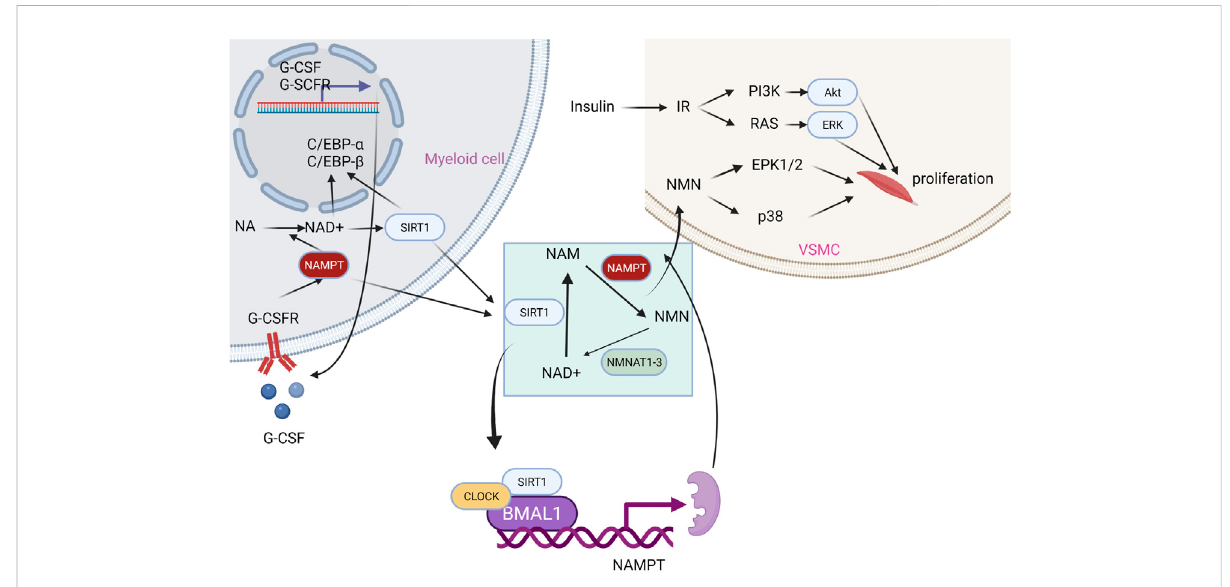
FIGURE 3 Effects of NAMPT on different physiological